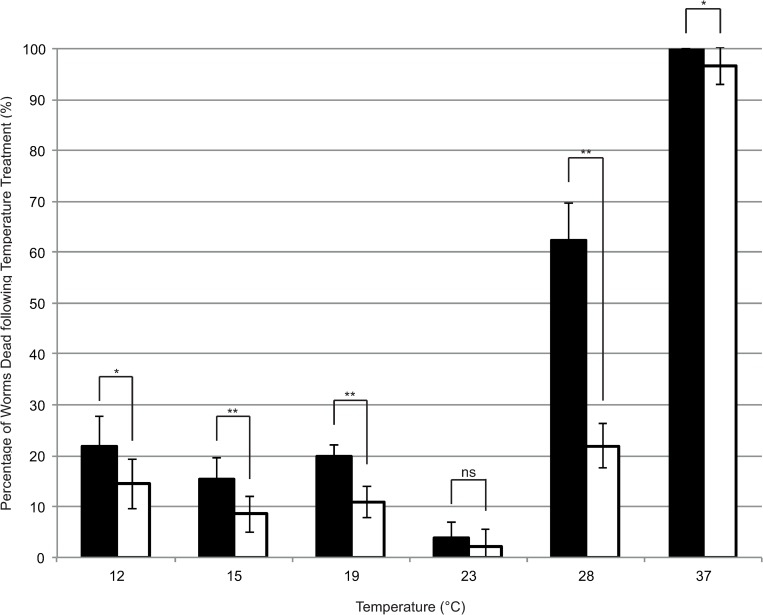
daf-12(RNAi) worms (black) have decreased tolerance to temperature stress compared to control worms (white).L1 larvae were soaked with a scrambled siRNA (control) or one targeting daf-12 (daf-12(RNAi)) and were then exposed to different temperatures for 4 hours, after which their survival was determined. Worms maintained at 12 and 37°C both had a statistically significant increase in death following temperature stress (p = 0.003 and p = 0.005). Worms maintained at 15, 19 and 28°C had a highly statistically significant increase in death following temperature stress (all p<0.001) whereas worms maintained at 23°C had no statistically significant difference in death (p = 0.083). Error bars represent standard deviation. The bars represent the mean percentage of worms dead post-heat shock, calculated from three biological replicates, each containing four technical replicates. Mann Whitney U analysis was performed to determine statistical significance. ns indicates a non-statistically significant difference (p-value >0.01), * indicates a statistically significant difference (p-value ≤0.01 - ≥0.001), ** indicates a highly statistically significant difference (p-value ≤0.001).